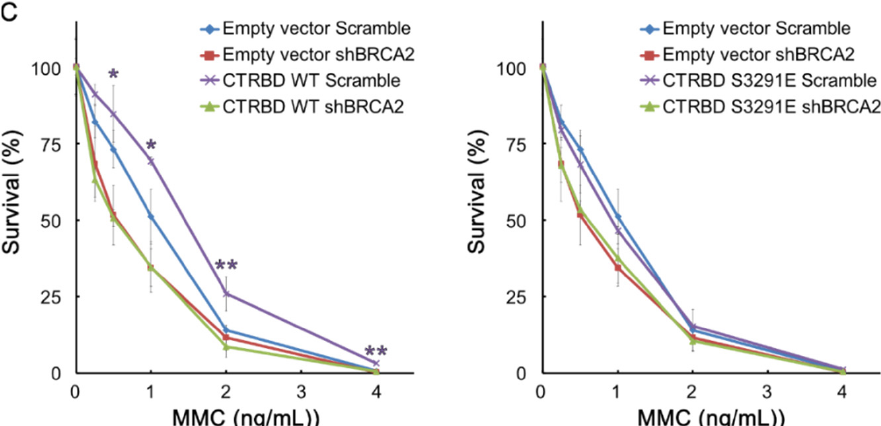
Figure 3. Resistance to X-ray irradiation conferred by the CTRBD expression depends on endogenous BRCA2. ( A ) Expression of endogenous BRCA2 in empty vector-transduced cells and wild-type or S3291E-mutated CTRBD-expressing cells was determined via Western blotting using anti-BRCA2 antibody in BRCA2-depleted HeLa cells generated by the shRNA-mediated knockdown of BRCA2 . ( B , C ) A clonogenic survival assay of BRCA2-depleted cells after X-ray irradiation or MMC treatment is shown. Results are indicated as the mean at each X-ray or mitomycin C (MMC) dose, and error bars indicate the standard deviation ( n = 3). Significance was examined by an F-test, followed by Student’s t -test with Holm’s correction. Asterisks indicate significant differences between empty vector-transduced HeLa cells and FLAG-HA-fused wild-type or S3291E-mutated BRCA2 CTRBD- expressing cells (* p < 0.05, ** p < 0.01).